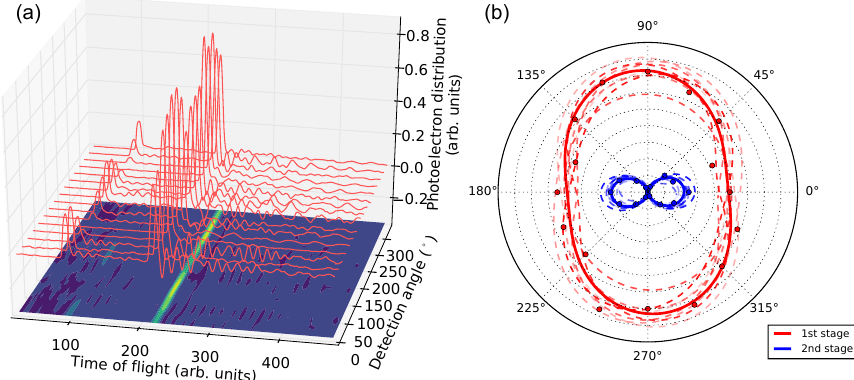
Figure 4. ( a ) photon energy spectra from the 16 channels of the eTOF polarimeter (average over 50 shots). The peak around 200 (arb. units) along the time-of-flight axis corresponds to the emission from the first stage and the peak around 100 (arb. units) corresponds to the second stage emission; ( b ) processed photon angular distribution of the first stage ( red ) and the second stage ( blue ) radiation. The dashed curves are single shot PADs while the solid line is an average over 50 shots. The lines are results from the fitting of data (points) with Equation